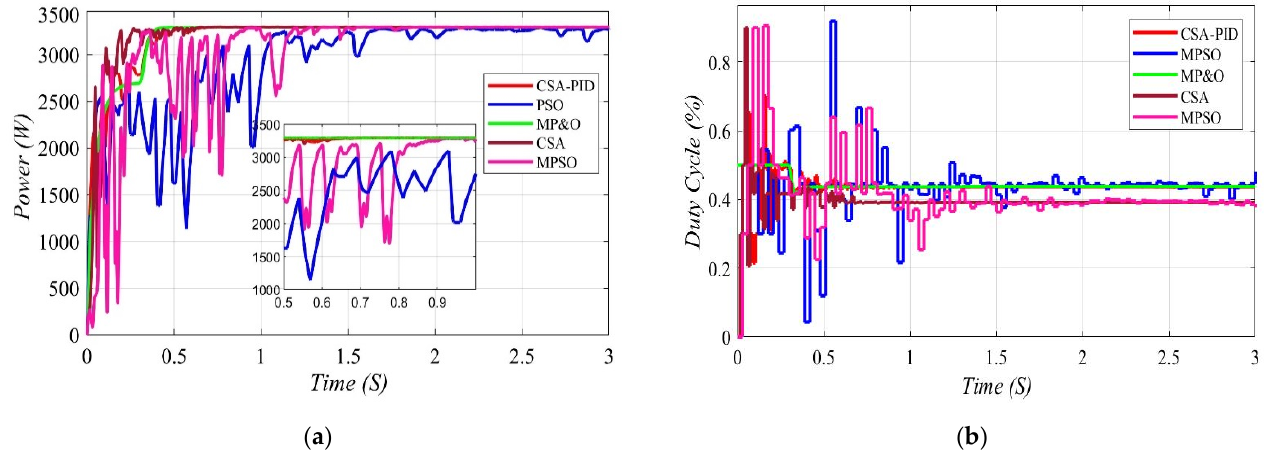
Figure 19. Details of duty cycle and power of proposed CSA-PID, CSA, MPSO, PSO, and MP&O controllers under scenario three. ( a ) The output power of proposed CSA-PID, CSA, MPSO, PSO, and MP&O. ( b ) The output duty cycle of proposed CSA-PID, CSA, MPSO, PSO, and MP&O.